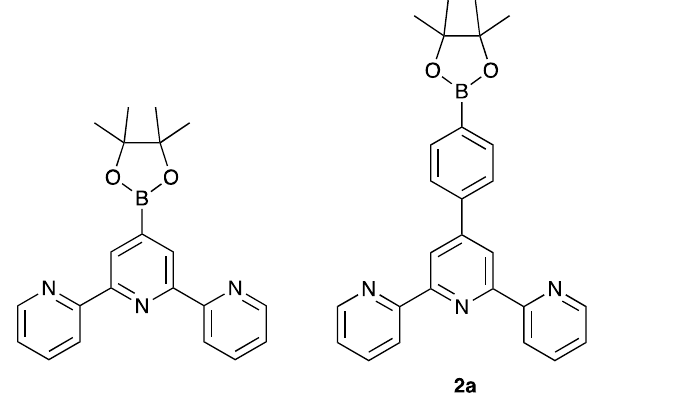
Scheme 4. Structures of the previously reported compounds 4 ′ -(4,4,5,5-tetramethyl-1,3,2-dioxaborolan-2-yl)-2,2 ′ :6 ′ ,2 ″ -terpyridine [23] and (4,4,5,5-tetramethyl-1,3,2-dioxaborolan-2-yl)phenyl]-2,2 ′ :6 ′ ,2 ″ -terpyridine ( 2a ) [20].